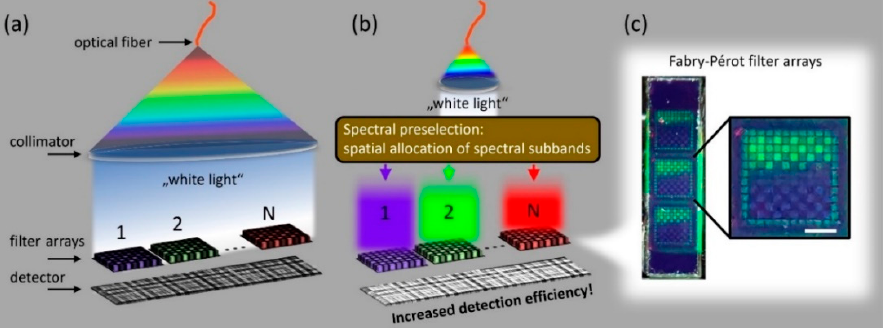
Figure 8. Basic principle of efficiency enhancement of filter-based spectrometers. ( a ) Typical case without spectral preselection: filter arrays are illuminated with broadband light. ( b ) Special optics “spectrally preselects” the incoming light to illuminate correspondent filter arrays. Thus, efficiency increase is achieved, and the filters transmit more light. ( c ) Photo of illuminated FP filter arrays (with scale bar of 200 µm, in gray).